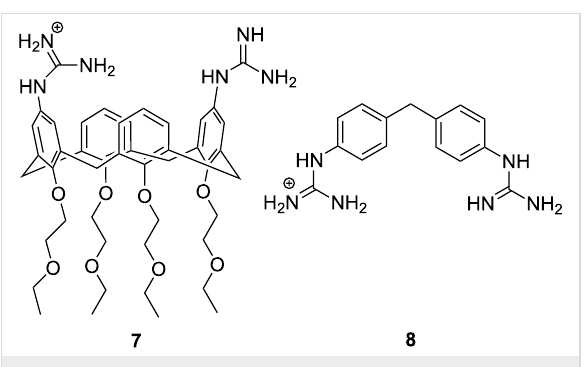
Figure 8: Bifunctional guanidine/guanidinium group-based cleaving agents of RNA.